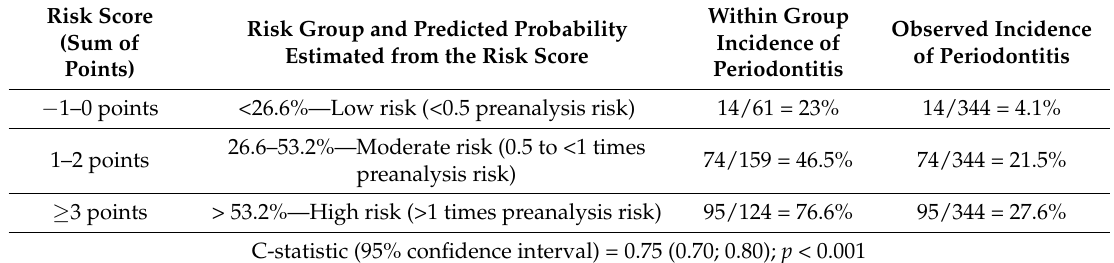
Table 3. Observed incidence of periodontitis in the three risk groups.